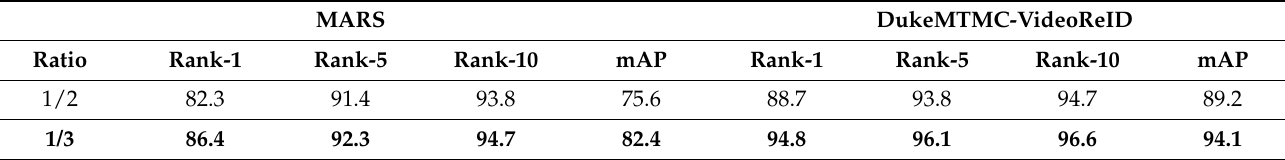
Table 5. Comparison of the impact of different erasure height ratios on network performance.